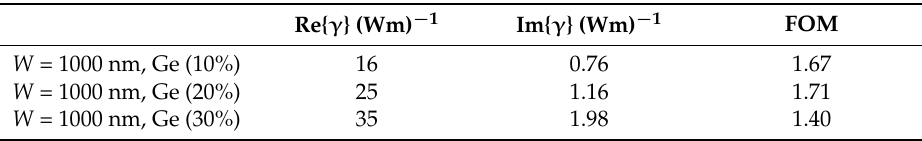
Table 4. Nonlinear parameters for three selected SiGe waveguides.